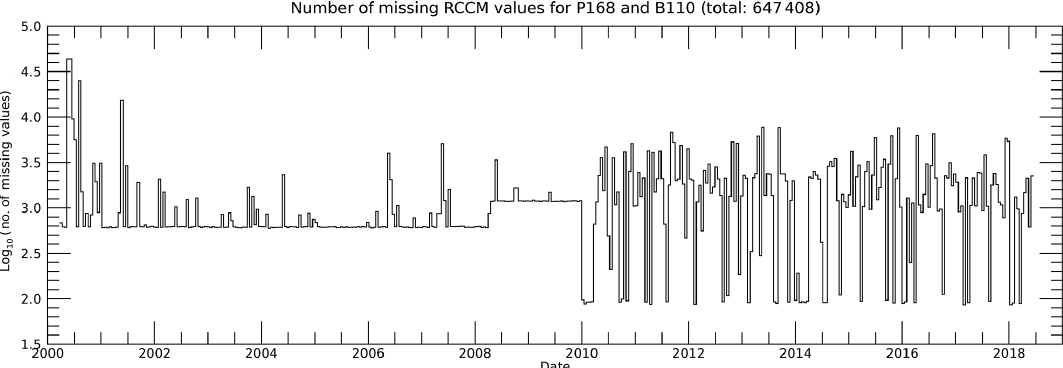
Figure 8. Plot of the number of missing RCCM values for Path 168 and Block 110, as a function of time (i.e., for all available Orbits) between the start of the mission and mid-2018 (about 650000 out of a total on the order of 177 million values). This is a semilogarithmic plot, so each vertical step of one unit represents an order-of-magnitude more missing points (see text for